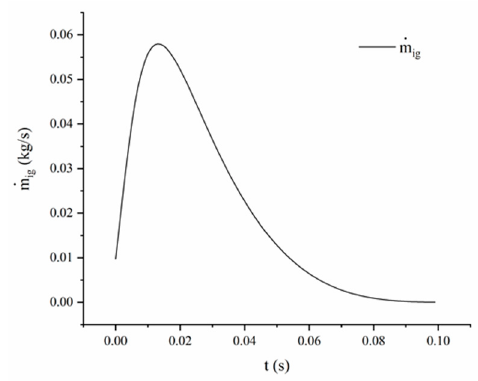
Figure 3. Igniter mass flow history.